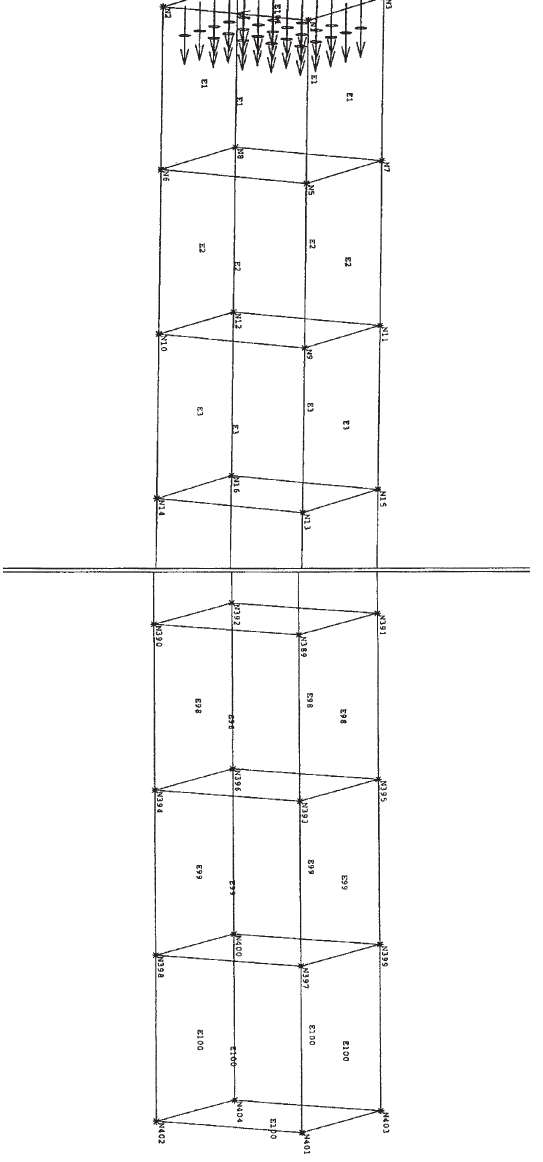
Fig. 1. Bleich–Sandler model. Fig. 2. Bleich–Sandler plate velocity and pressure (CFA